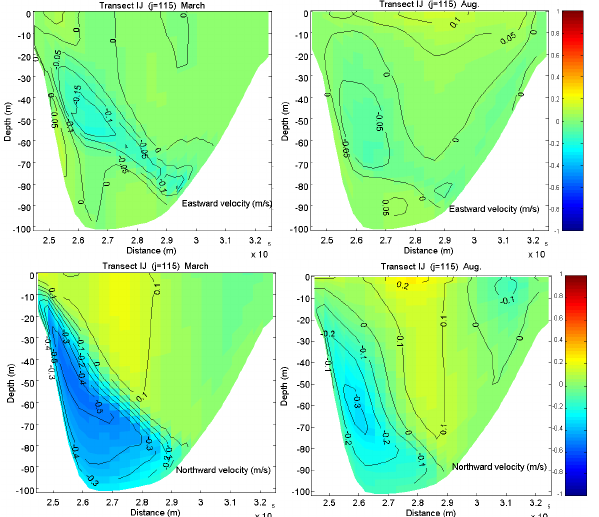
Fig. 13. Cross-section of the mean temperature and salinity along the MN path, shown in Fig. 5 obtained from model simulation dur- ing March (left) and August